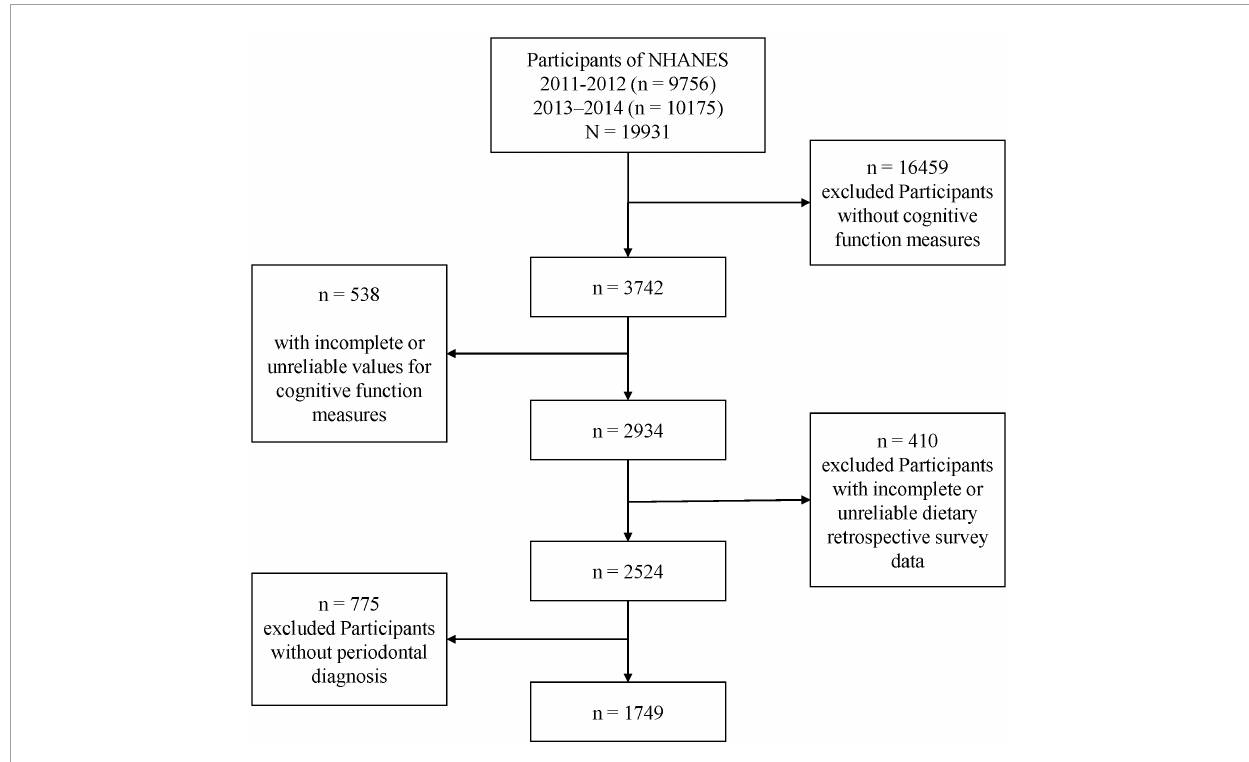
FIGURE1 Flow chart for the selection of included sample.